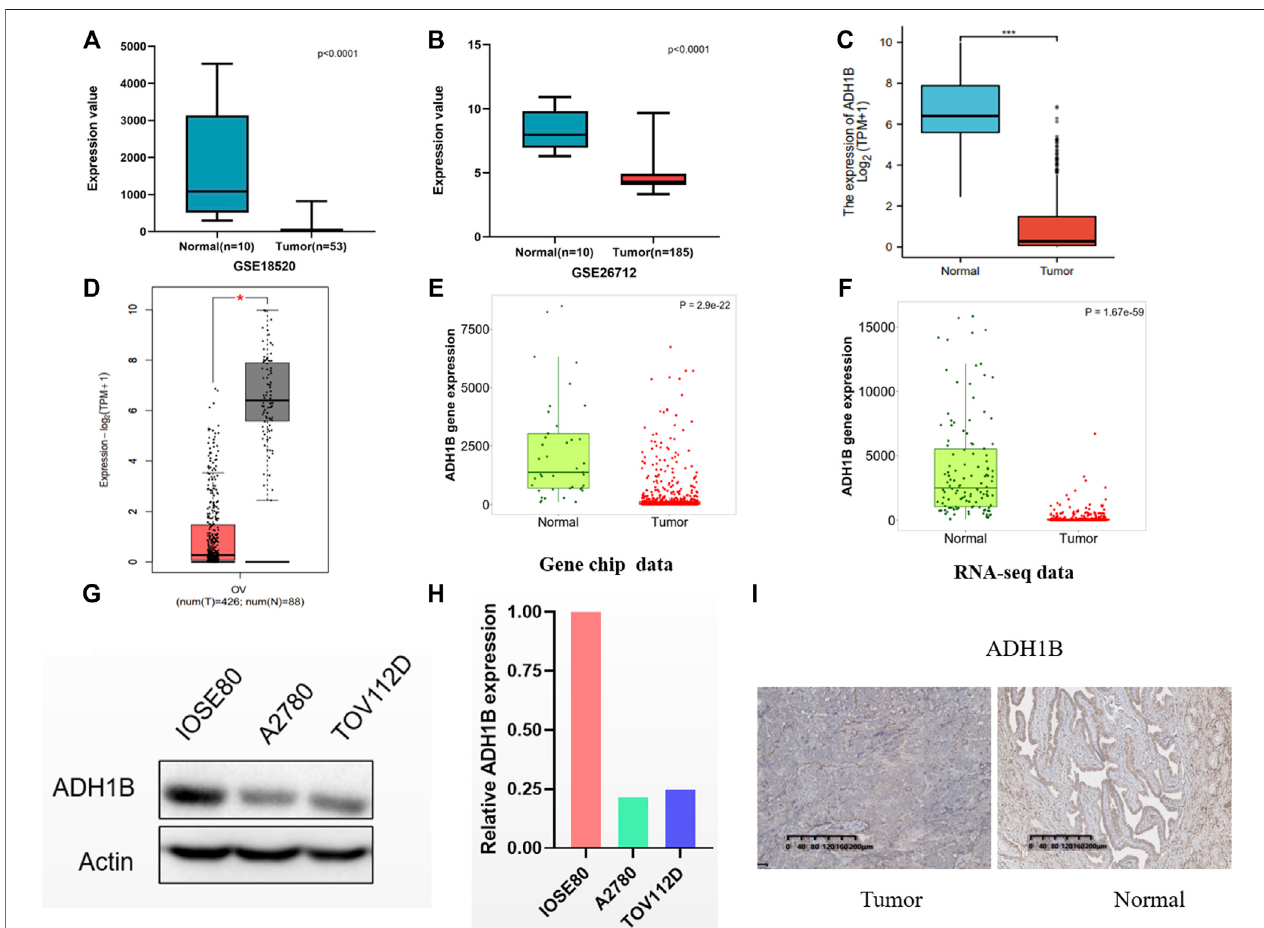
FIGURE 3 | The expression of ADH1B in ovarian cancer tissues. (A – D) Compared with normal ovarian tissue, a signi fi cantly reduced ADH1B could be obtained in GSE18520 (A) ,GSE26712 (B) ,TCGA-OV (C) ,andGEPTA2 (D) . (E,F) Theveri fi cationofdown-regulatedexpressionlevelofADH1BusingTNMplotdatabasefromgene chip data (E) and RNA-seq data (F) . (G,H) ADH1B was downregulated in two OV cells, A2780 and TOV112D. (I) Immunohistochemical analysis indicated the downregulated ADH1B in OV patients. * p < 0.05; *** p < 0.001.